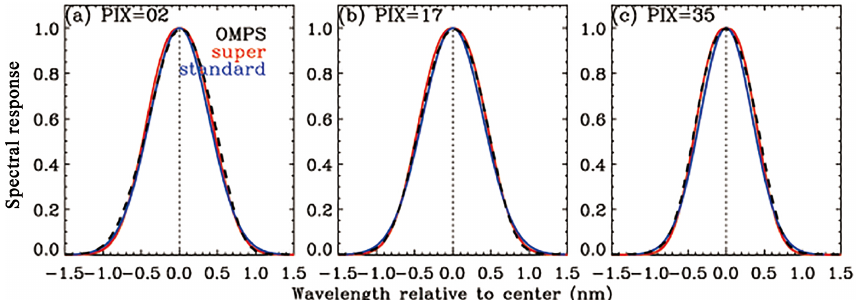
Figure 3. Comparison of OMPS-measured slit measurements (black) and derived slit functions assuming a standard Gaussian (red) and super Gaussian (blue) for orbit